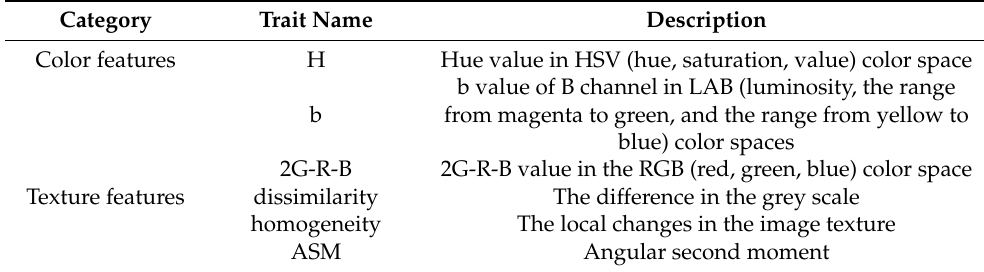
Table 1. Descriptions of the selected phenotypic features extracted from